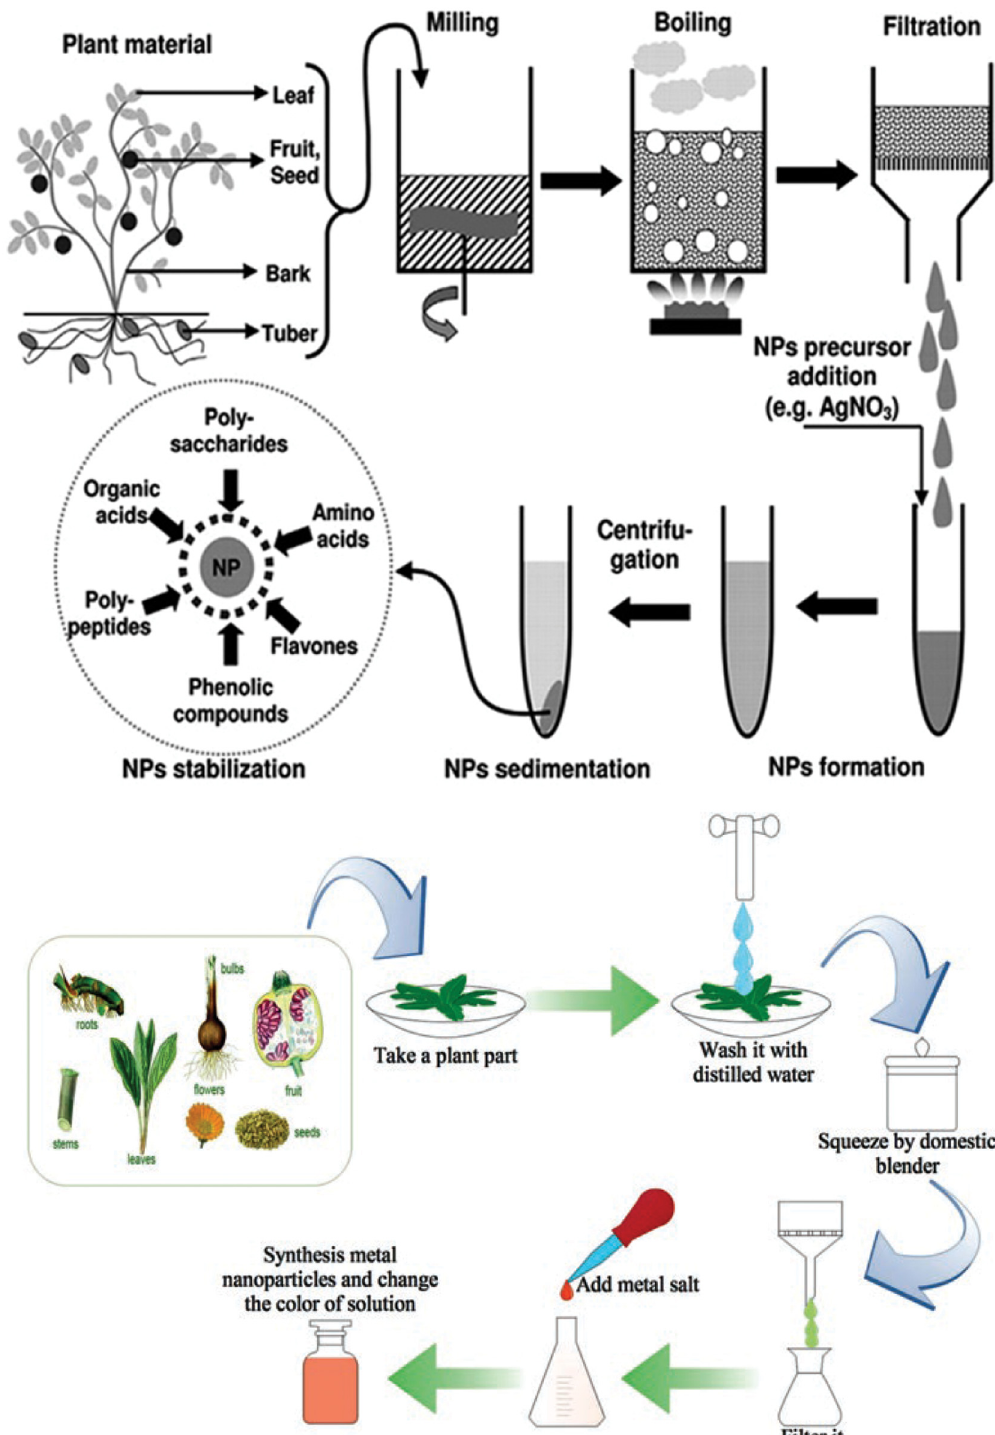
Figure 3: Two schematic features of MNP synthesis using plant extracts [ 29,30 ]